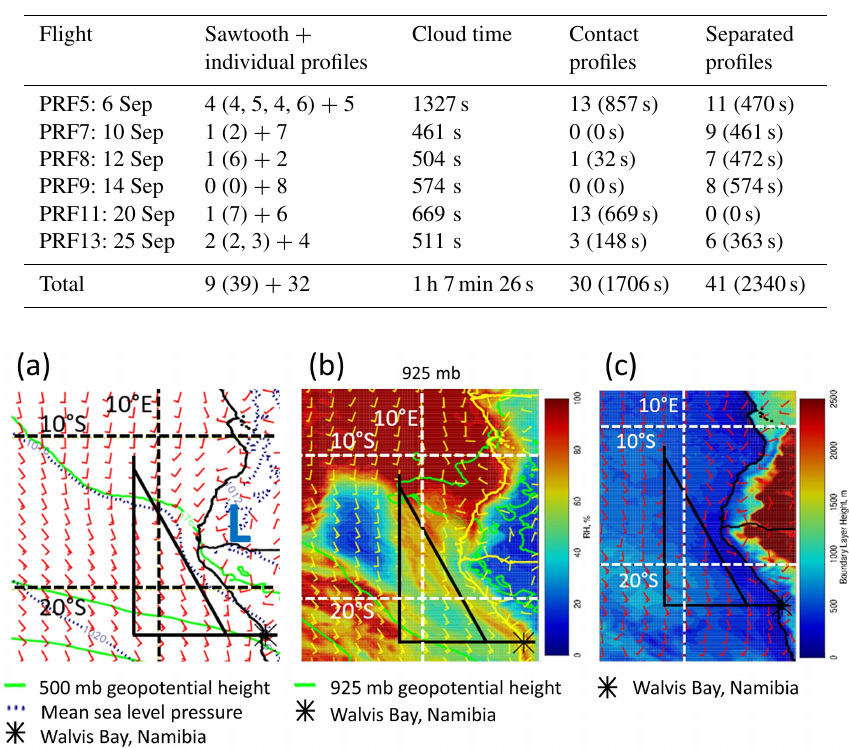
Table 2. List of research flights analyzed with the number of cloud profiles flown and total time spent profiling clouds during each flight. The number of profiles during sawtooth maneuvers are reported within parentheses. The number of profiles and the corresponding sampling time are reported for contact and separated profiles during each flight.